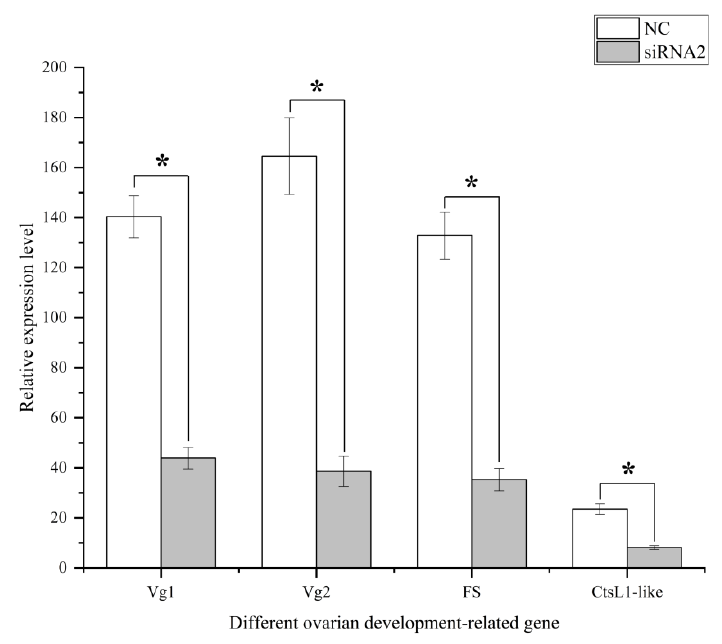
Figure 9. Expression analysis of ovarian development-related genes in the ovary after the silencing of Sj ILPR. Expression levels of each gene are compared to their respective control levels. The results are expressed as mean ± SD (n = 8). Statistical significance is indicated by asterisks (*).